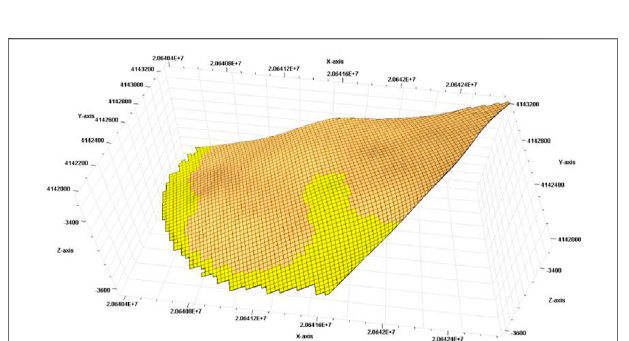
FIGURE 8 | The sedimentary facies model of the No. 3 sand formation, No. 3 sublayer, member 4 of Shahejie Formation in the Wang 587 Block.